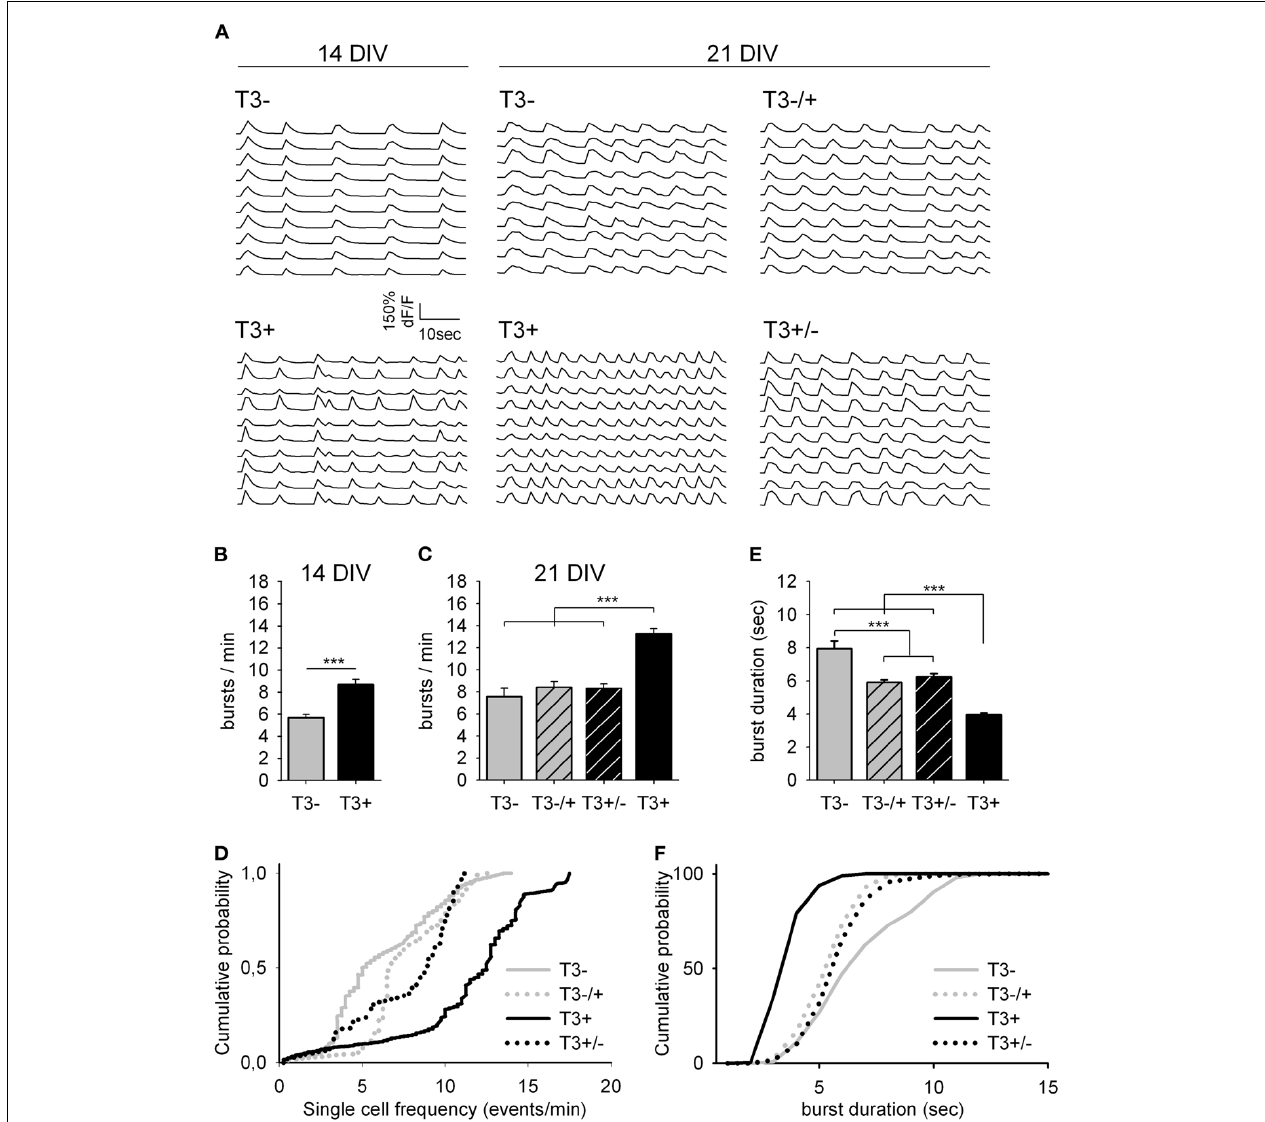
FIGURE 3 | Spontaneous network activity at 14 and 21DIV. (A) . Traces show the change in intracellular calcium signals of individual neurons from 14- or 21-day-old cultures grown either in the absence or presence of T3, as indicated. (B) . T3 increases the burst frequency at 14DIV. (C) . The maximal burst frequency at 21DIV was measured in cultures chronically treated with